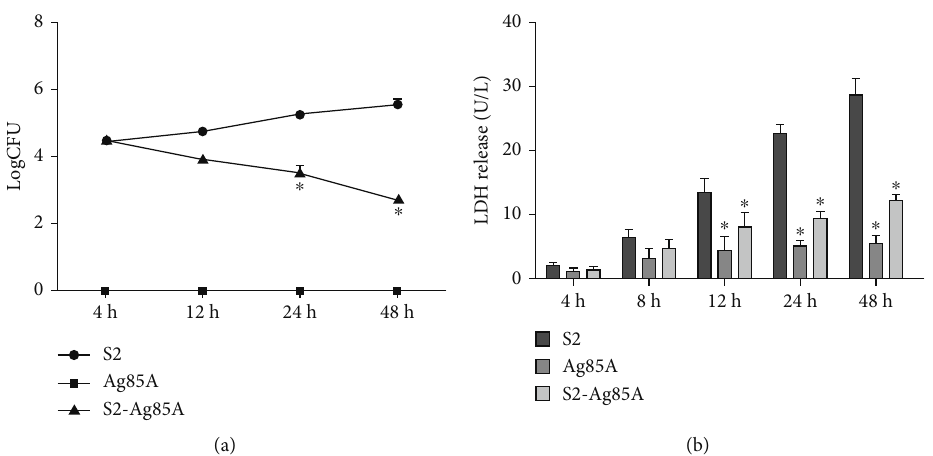
Figure 2: The S2-Ag85A oral vaccine can e ff ectively inhibit the replication of Brucella in vitro. (a) The initial inoculation levels of S2, Ag85A, and S2-Ag85A were the same. After 12 hours of infection, the bacterial count was gradually increased in the S2 group from the baseline, and the bacterial count was gradually decreased in the S2-Ag85A. At 24h and 48 h, the counted level of the virus was signi fi cantly decreased in the S2-Ag85A group than in the S2 group ( P value < 0.05). (b) The releasing level of LDH in cells of each group at 4h, 24 h, and 48h was not signi fi cantly di ff erentiated. There was a signi fi cantly lower level of LDH in the Ag85A group and S2- Ag85A group than that in the S2 group ( P value < 0.05). ∗ P value < 0.05 compared to the Ag85A group. Table 1: Detection of hemolytic activity.